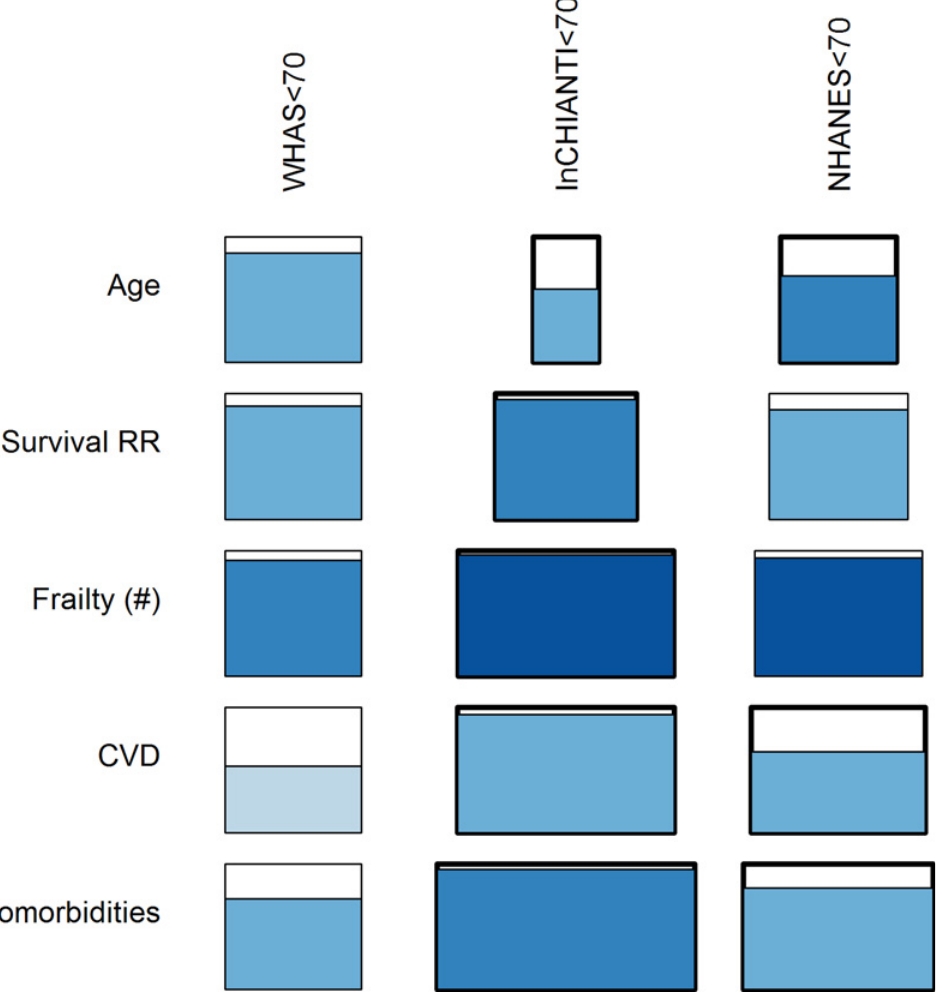
Fig 9. Effects of RP drawn from external young populations on prediction of age and health outcomes. The study population represented here is the full WHAS data set with young RPs from each of the three data sets as indicated. The width of the rectangle represents the average effect size among significant analyses, relative to the effect size of the rectangle in the leftmost column (entire study population as its own RP). The percentage of significant p- values is represented by the height of shading within the rectangle, the shading colour represents the direction of the effect (blue is a positive effect), and the hue represents the average p -value among the significant p-values, with darker hues indicating lower p -values.